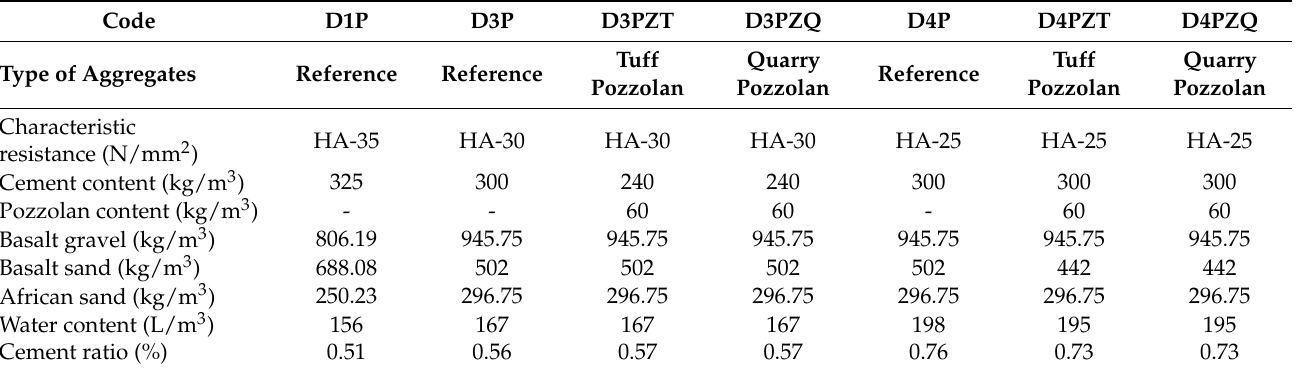
Table 2. Identification, classification and characteristics of all concrete samples tested. All were made with type II/A-P/42.5R MR